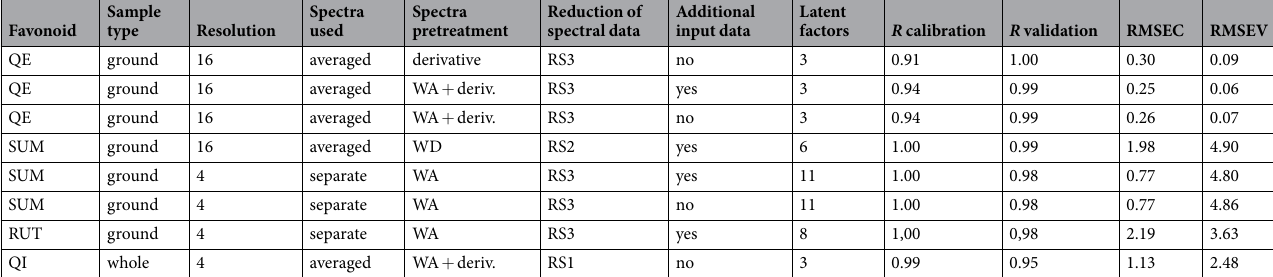
Table 1. Parameters of 6 models with RMSEV comparable to the SD of the HPLC data for quercetin (QE) and the sum of flavonoids (SUM), and of the best models for rutin (RUT) and quercitrin (QI) that are presented in Fig. 1. All these models were obtained on flower samples.